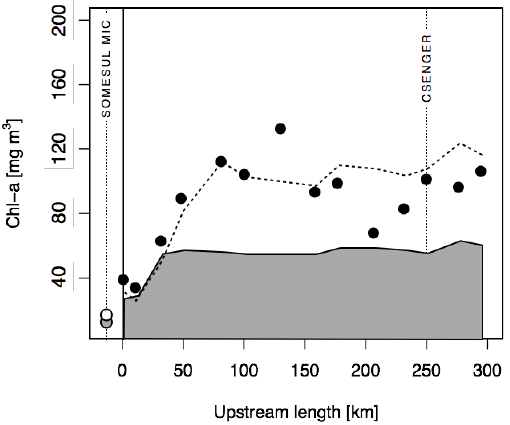
Figure 2. Observed and simulated summer mean Chl profiles along the Szamos River. Closed circles: observed in the extremely dry year of 2012. Grey region: simulated long-term summer mean; Dotted line: simulated mean for 2012; “Upstream length” is 0 km at the city of Dej and maximal at the confluence with River